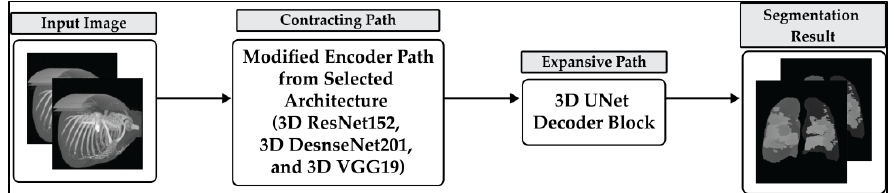
Figure 2. The general segmentation process with scenario of 3D U-Net modified